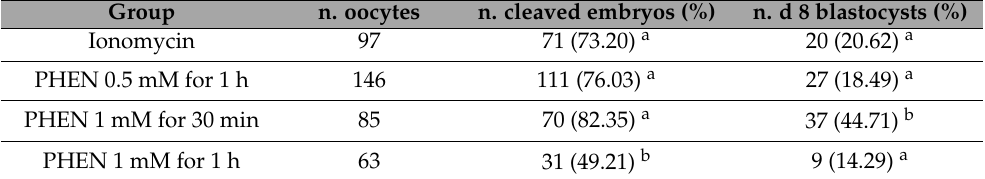
Table 4. In vitro preimplantation development of parthenogenetic porcine embryos using Zn chelator PHEN in Talp-h media at different incubation conditions.